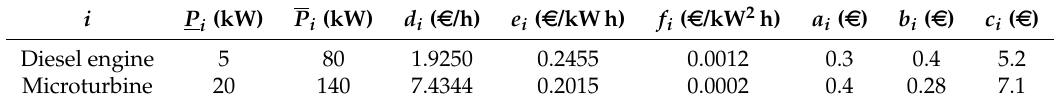
Table 1. Characteristic parameters of each of the generators considered in the MG.